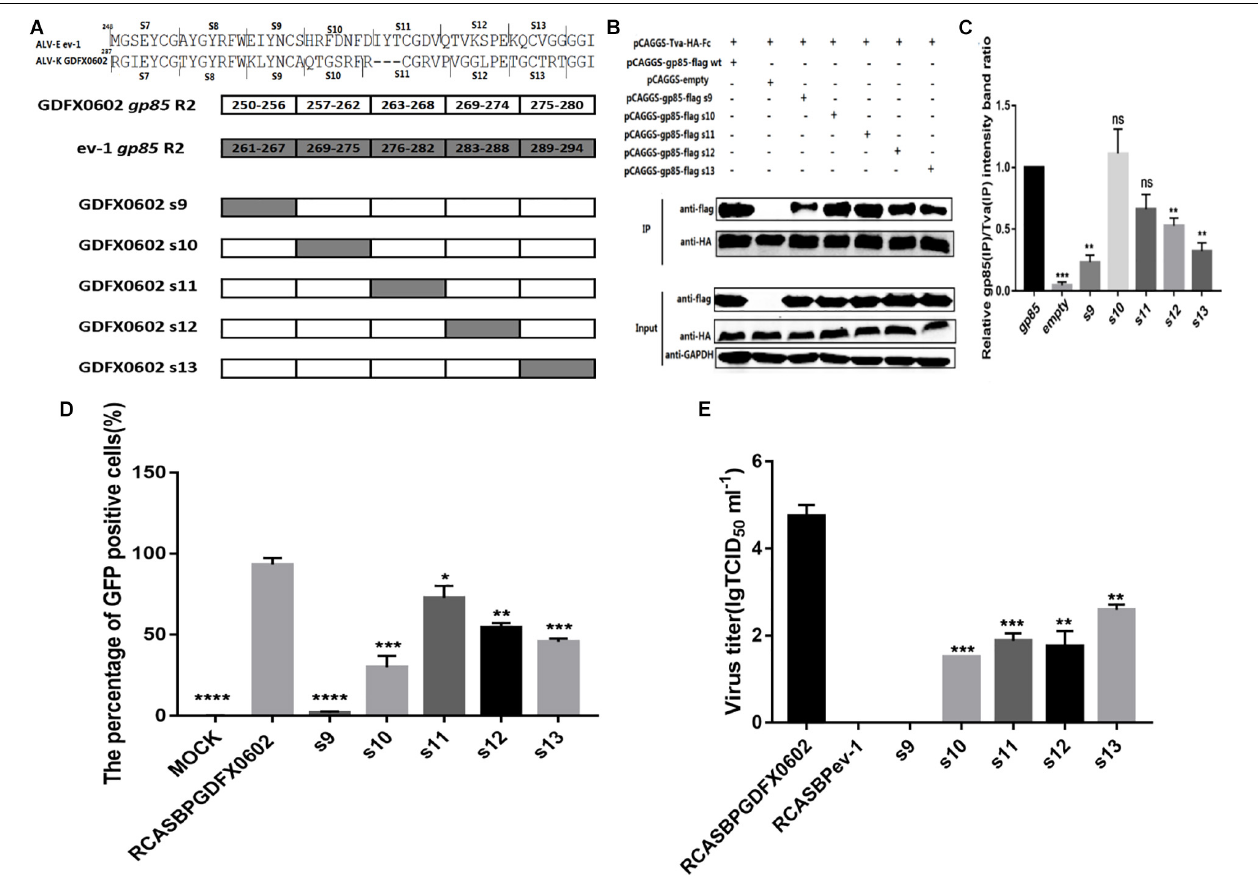
FIGURE 5 | Residues 251–256 between hr1 and hr2, and residues 269–280 in hr2 of ALV-K gp85 were the key residues binding to Tva. (A) The relationship between residues R2 (aa237–280) and s7–s13. (B) The interaction of soluble chimeric proteins gp85-flag s9–s13 with Tva-HA-Fc. (C) The level of protein was quantified using Image StudioLiteVer 5.2, and soluble chimeric proteins gp85-flag (IP)/Tva-HA-Fc (IP) were calculated. (D) DF-1 cells transfected with recombinant plasmids RCASBP GDFX0602 s9–s13-EGFP were detected for the percentage of GFP-positive cells by fluorescence-activated cell sorting. (E) The supernatant was collected and diluted in gradient to determine the virus titers. Three independent experiments were performed, and data are shown as mean ± SD in triplicate from a representative experiment. Statistical analysis (two-way analysis of variance) was performed using GraphPad Prism 7; * P < 0.05, ** P < 0.01, *** P < 0.001, **** P <